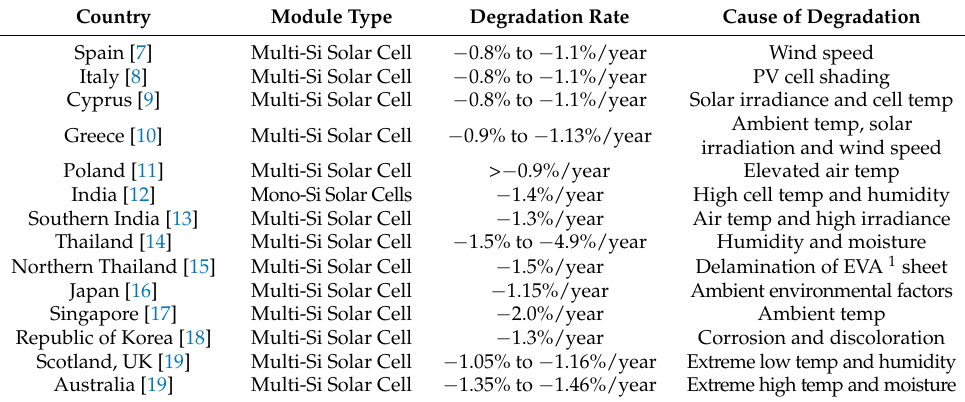
Table 1. Degradation rates reported from various